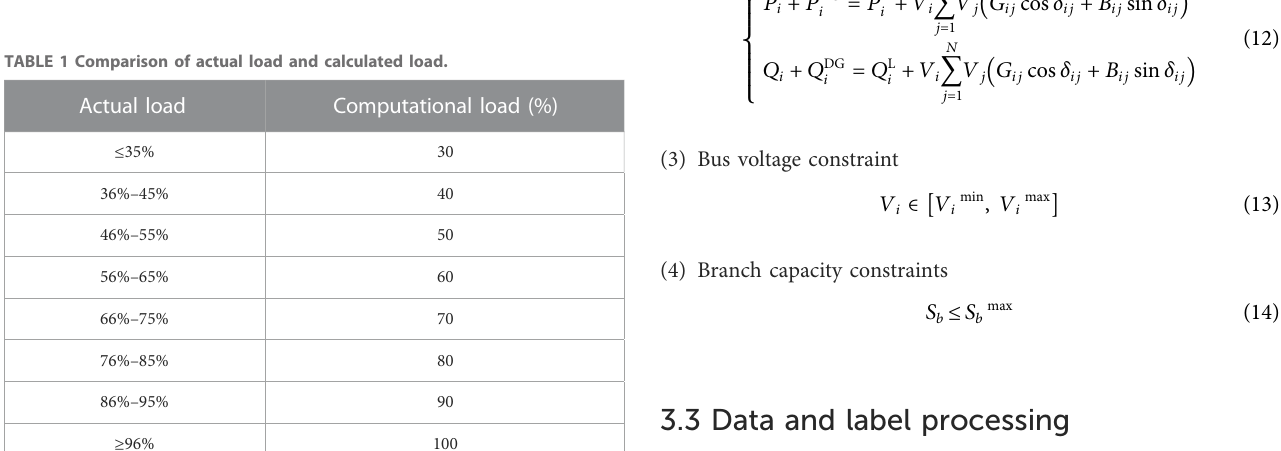
FIGURE 3 Data set construction process.